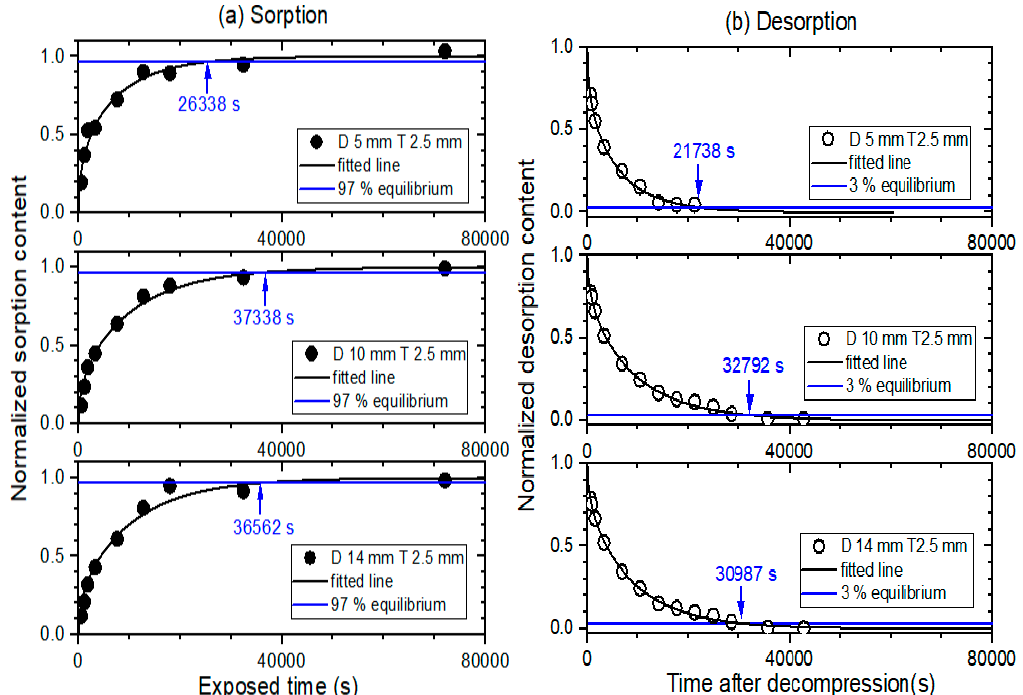
Figure 5. ( a ) Normalized sorption content versus exposed time and ( b ) desorption content versus time after decompression for cylindrically-shaped NBR with a diameter of 5 mm and thickness of 2.5 mm, a diameter of 10 mm and thickness of 2.5 mm, and a diameter of 14 mm and thickness of 2.5 mm. D and T represent the diameter and thickness, respectively. The normalized sorption and desorption contents were obtained by the sequences in Figure 2a and b, respectively. The values indicated by the arrows are the equilibrium time measured in the sorption and desorption process. Figure 6a and b show the normalized sorption and desorption curves versus time, respectively, with varying thicknesses and similar diameters for NBR. The corresponding sorption equilibrium times (blue arrow) obtained for NBR were 36,562 s for a diameter of 14 mm and thickness of 2.5 mm; 124,905 s for a diameter of 12 mm and thickness of 5 mm; and 178,986 s for a diameter of 12 mm and thickness of 10 mm. The desorption equilibrium times (blue arrow) obtained for NBR were 30,987 s for a diameter of 14 mm and thickness of 2.5 mm; 60,777 s for a diameter of 12 mm and thickness of 5 mm; and 124,193 s for a